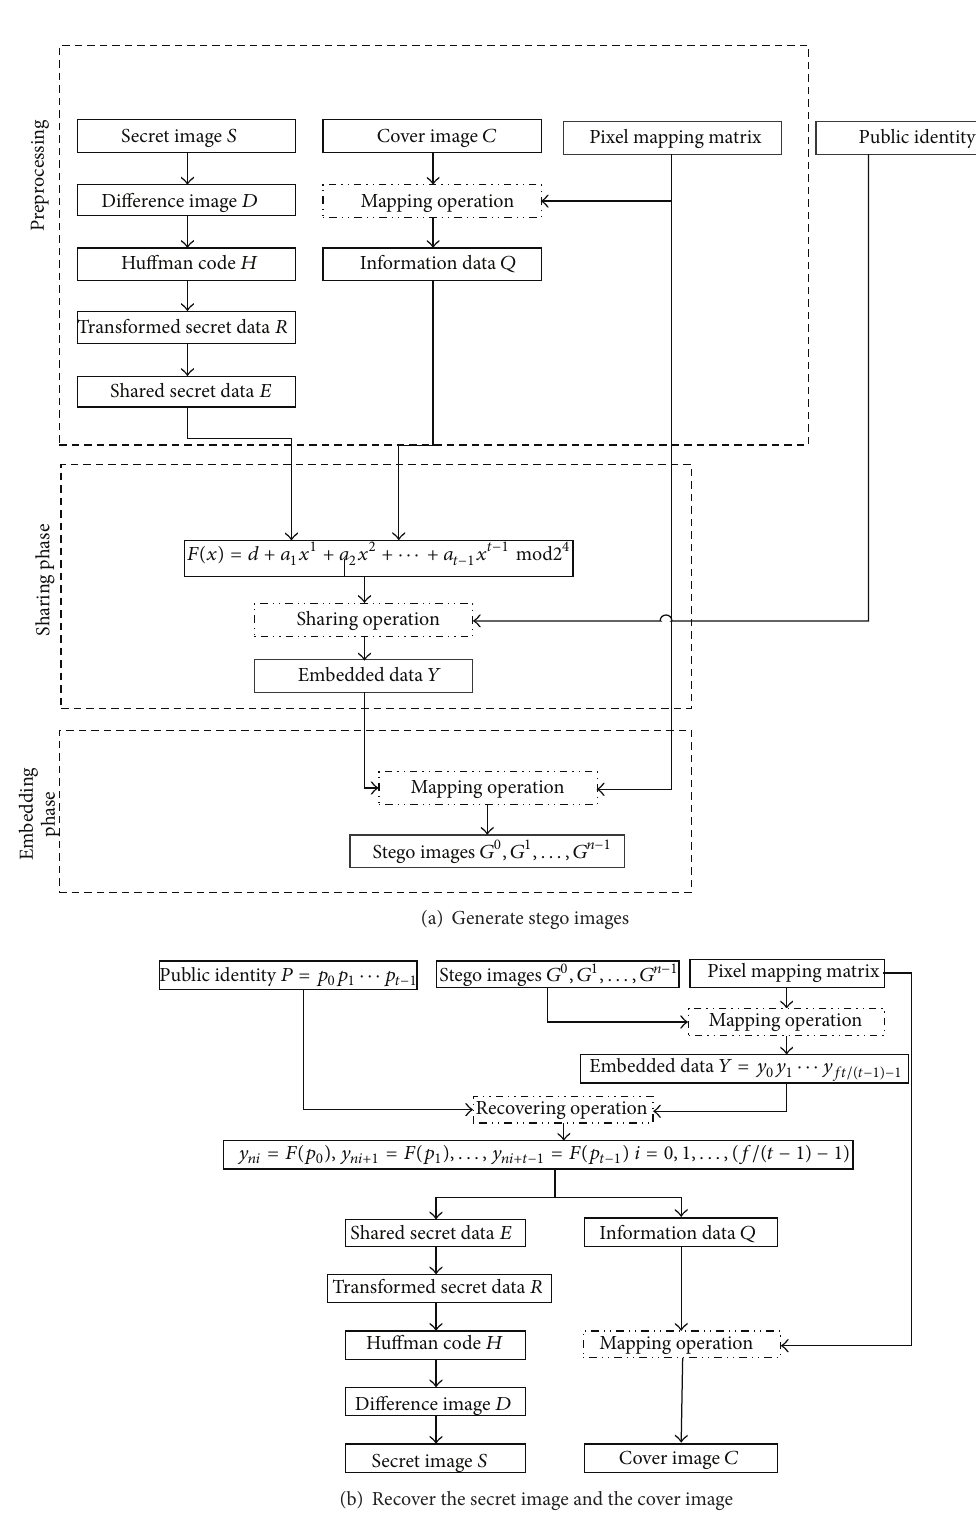
Figure 1: The flowchart of the proposed